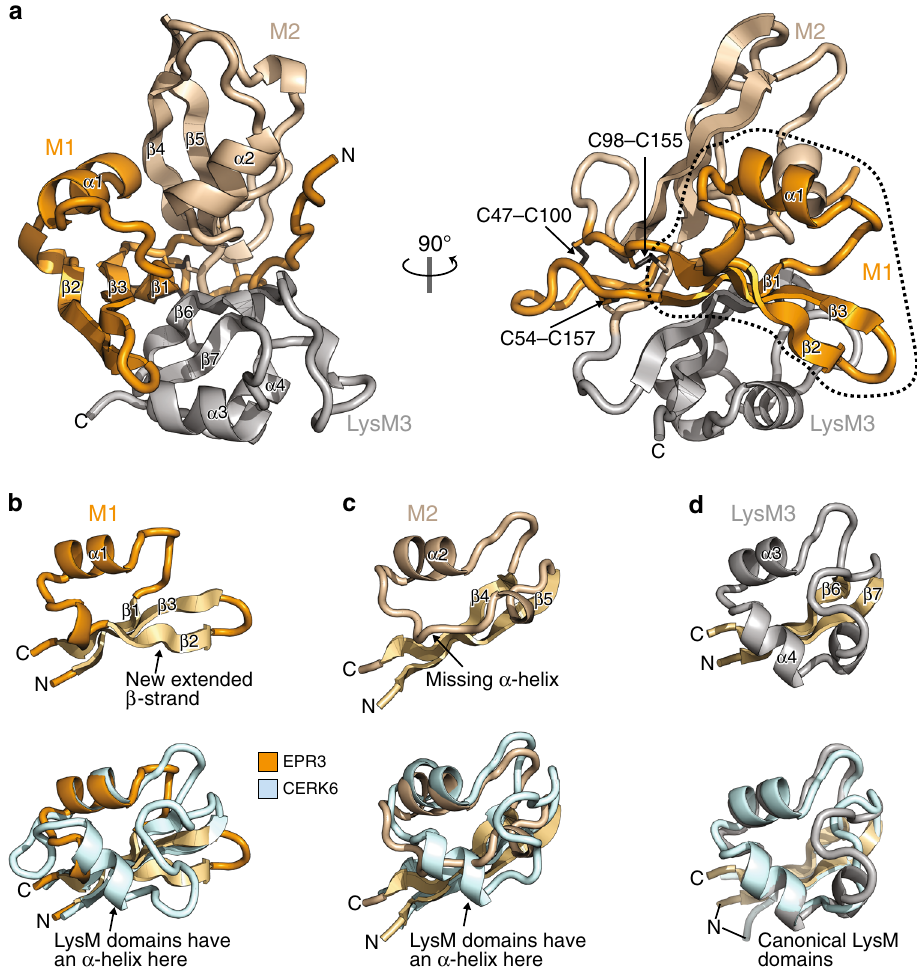
Fig. 1 The crystal structure of EPR3. a Cartoon representation of the EPR3 crystal structure with each of the modules M1, M2 and LysM3 coloured in orange, brown and grey, respectively. Secondary structure elements and disul fi de bridges are indicated. The dotted line highlights the unique M1 domain. b – d Individual carbohydrate-binding modules M1, M2 and LysM3 of EPR3 with labels indicating their secondary structures. The panels below show the modules superimposed on the corresponding LysM domains of CERK6 (PDB - 5LS2) coloured in light